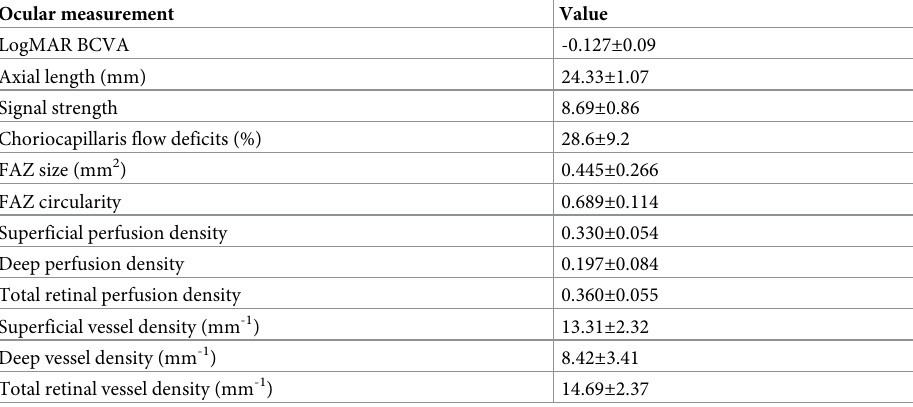
Table 2. Ocular measurements of the 36 patients.